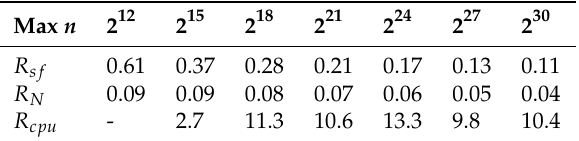
Table 5. Proportion of integers with idempotent factorizations.